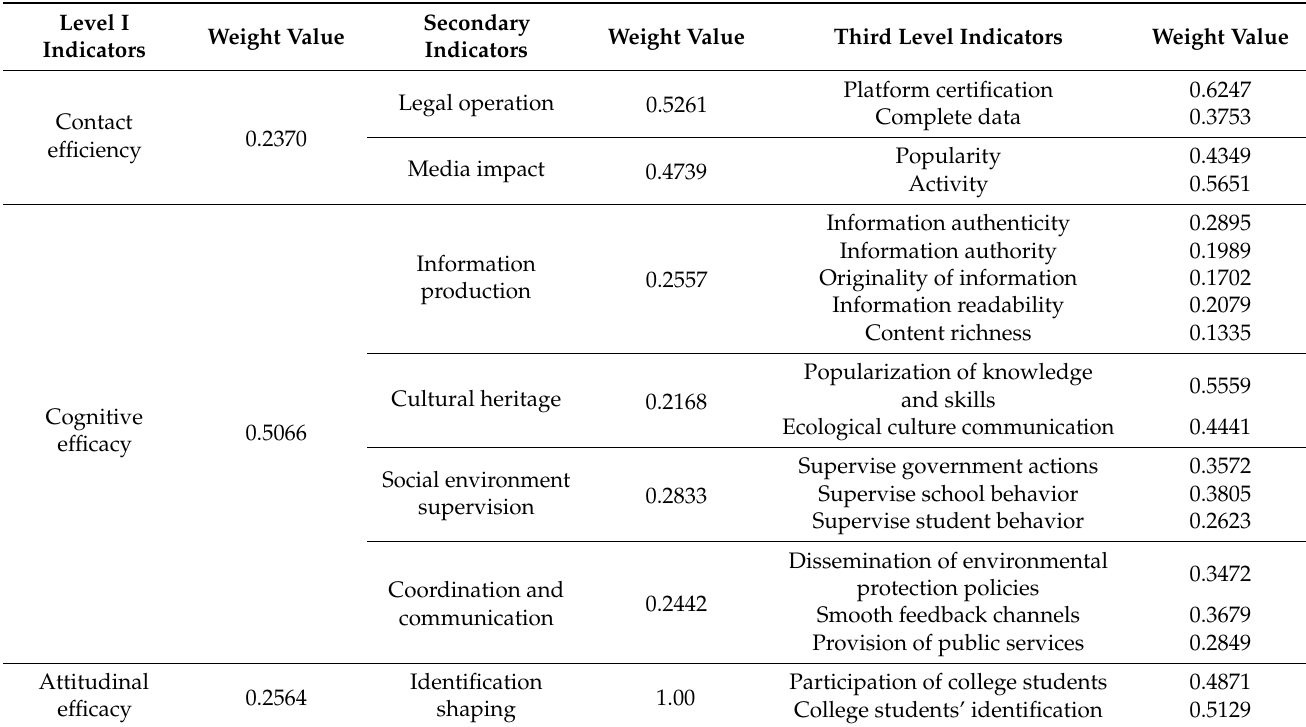
Table 4. Weights of evaluation indicators for communication efficiency of environmental protection education new media from the perspective of ideological and political education.